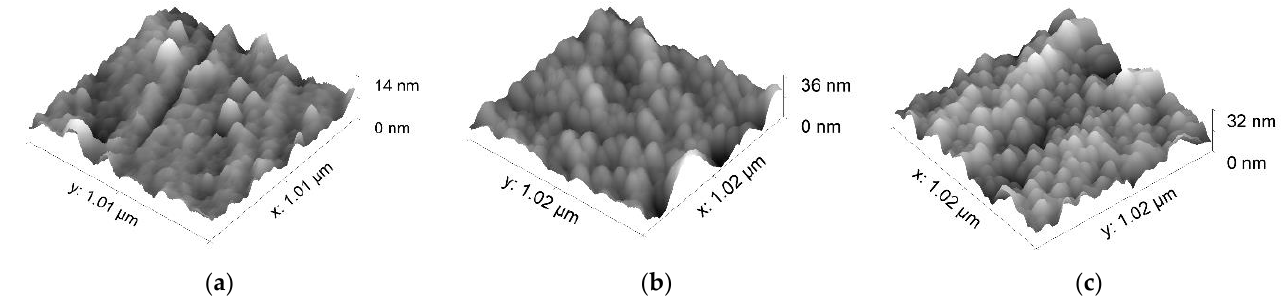
Figure 7. Micrograph of the surface of the films grown at different powers ( a ) 120 W ( b ) 190 W ( c ) 220 W. ( c ) 220